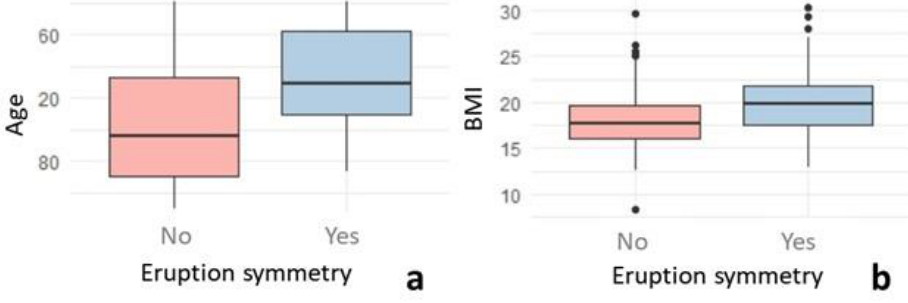
Figure 3. Dispersion diagram of age and BMI. Positive strong correlation between age and BMI. Correlation coefficient 0.549 ( p Value < 0.001).